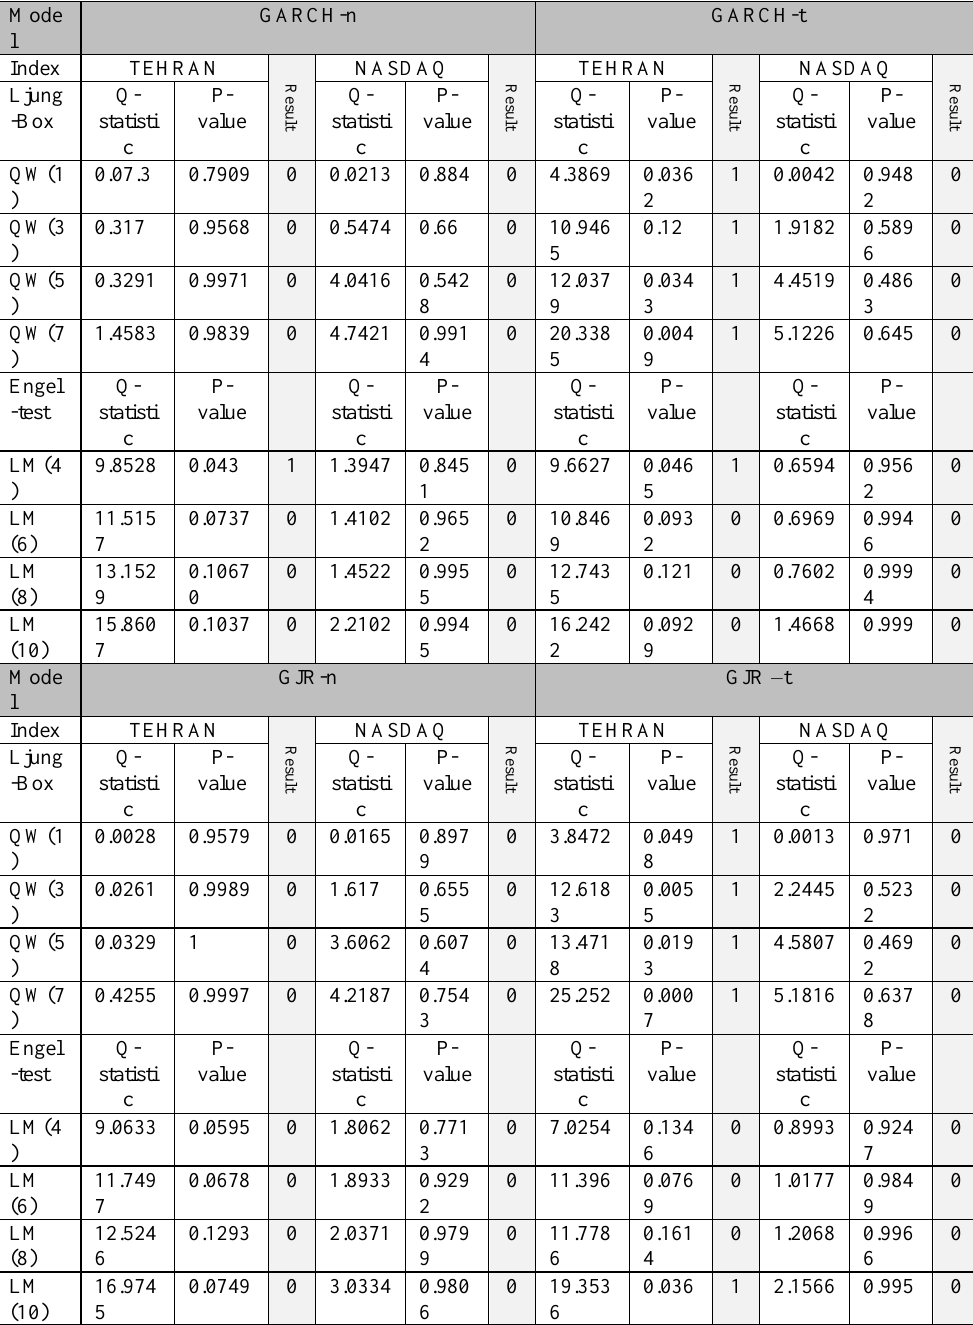
Table3. Estimation GARCH-GJR model and statistic